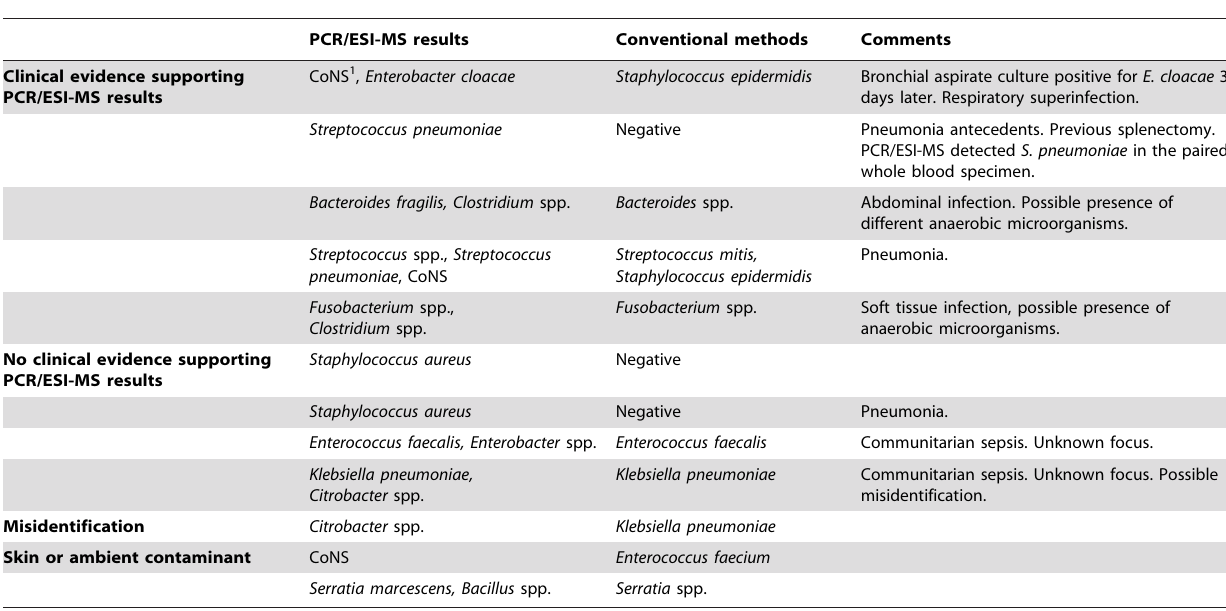
Table 5. Discrepancies found between the PCR/ESI-MS in blood cultures and conventional